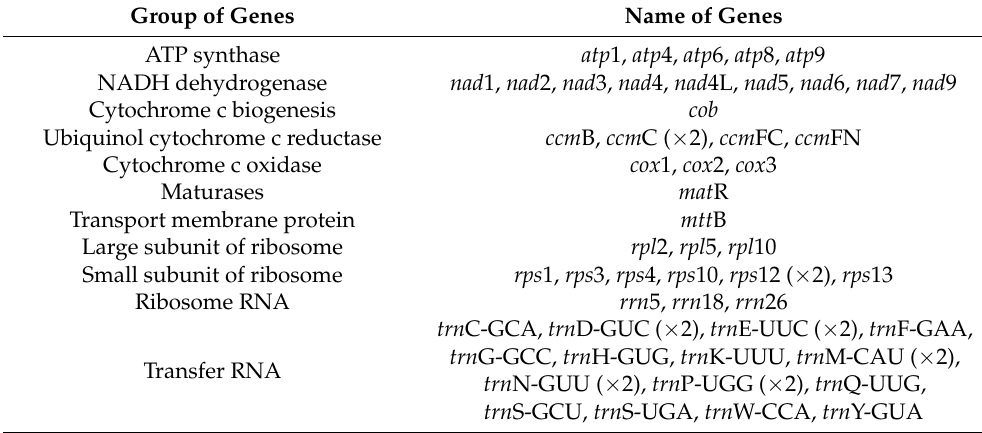
Figure 2. The circular maps of the mitochondrial genomes of G. elegans . Genomic features transcribed clockwise and counterclockwise are drawn on the inside and outside of the circle, respectively. Color-coding is used to distinguish genes of different functional groups. Table 1. Gene composition in the mitogenome of G. elegans .